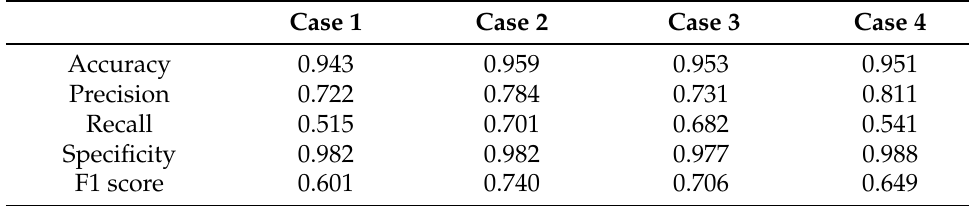
Table 5. Accuracy of detection